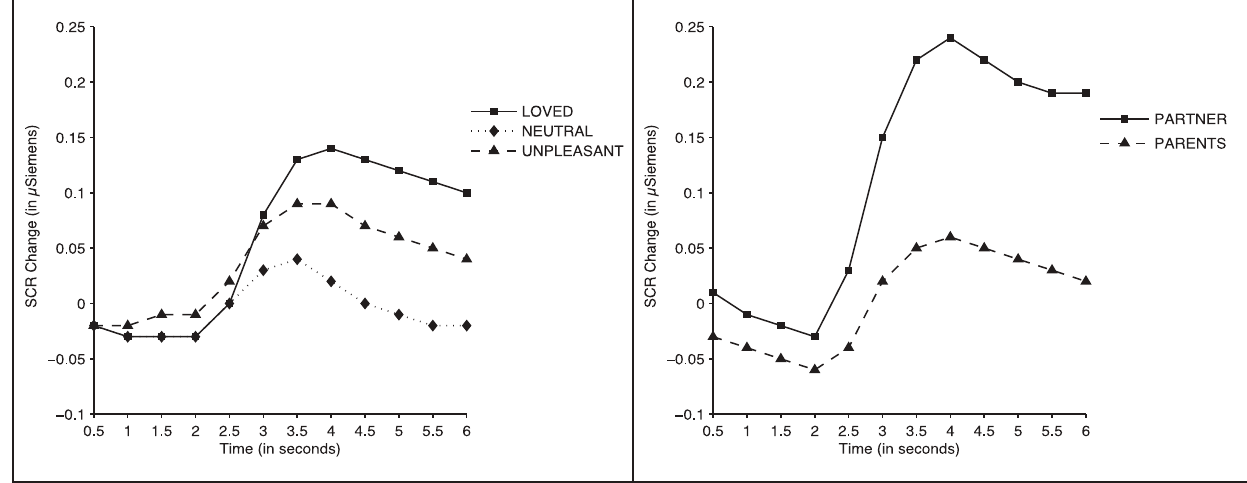
Figure 4. Skin conductance response to the faces. Skin conductance changes while participants viewed faces. Left: Loved vs. neutral vs. unpleasant faces. Right: Romantic partner (boyfriend/girlfriend) vs. same-sex parent (father/mot her) faces.